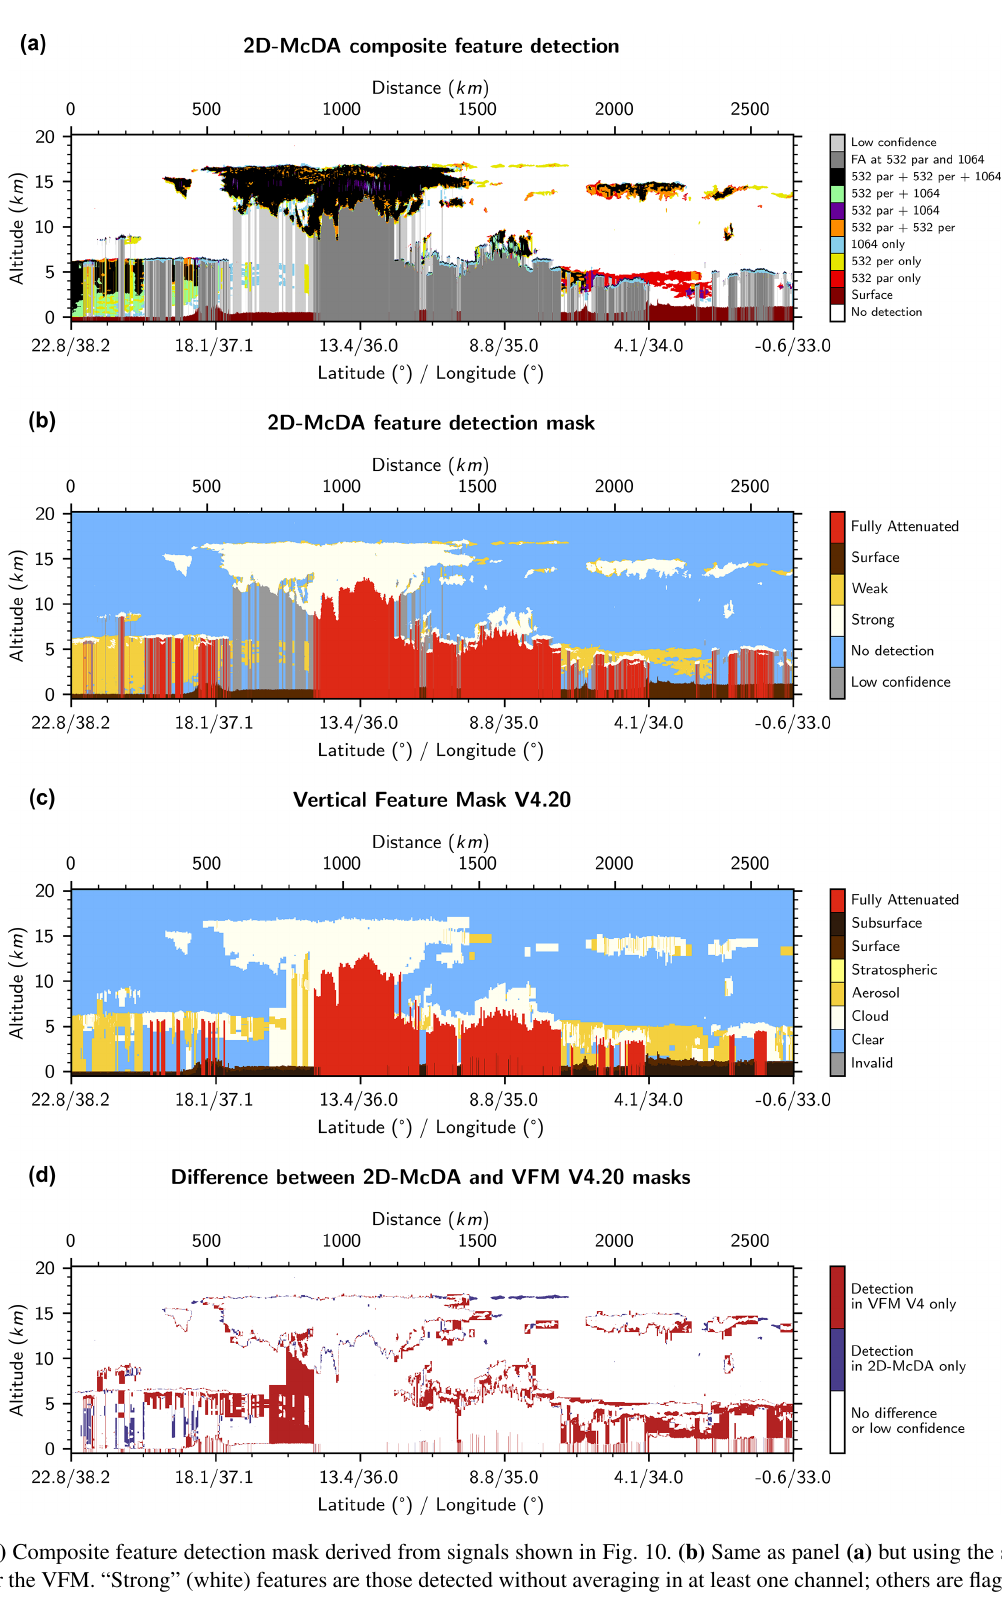
Figure 11. (a) Composite feature detection mask derived from signals shown in Fig. 10. (b) Same as panel (a) but using the same colors as those used for the VFM. “Strong” (white) features are those detected without averaging in at least one channel; others are flagged as “weak” (yellow). (c) VFM of version 4 of the CALIOP data product. (d) Difference between the new mask and the